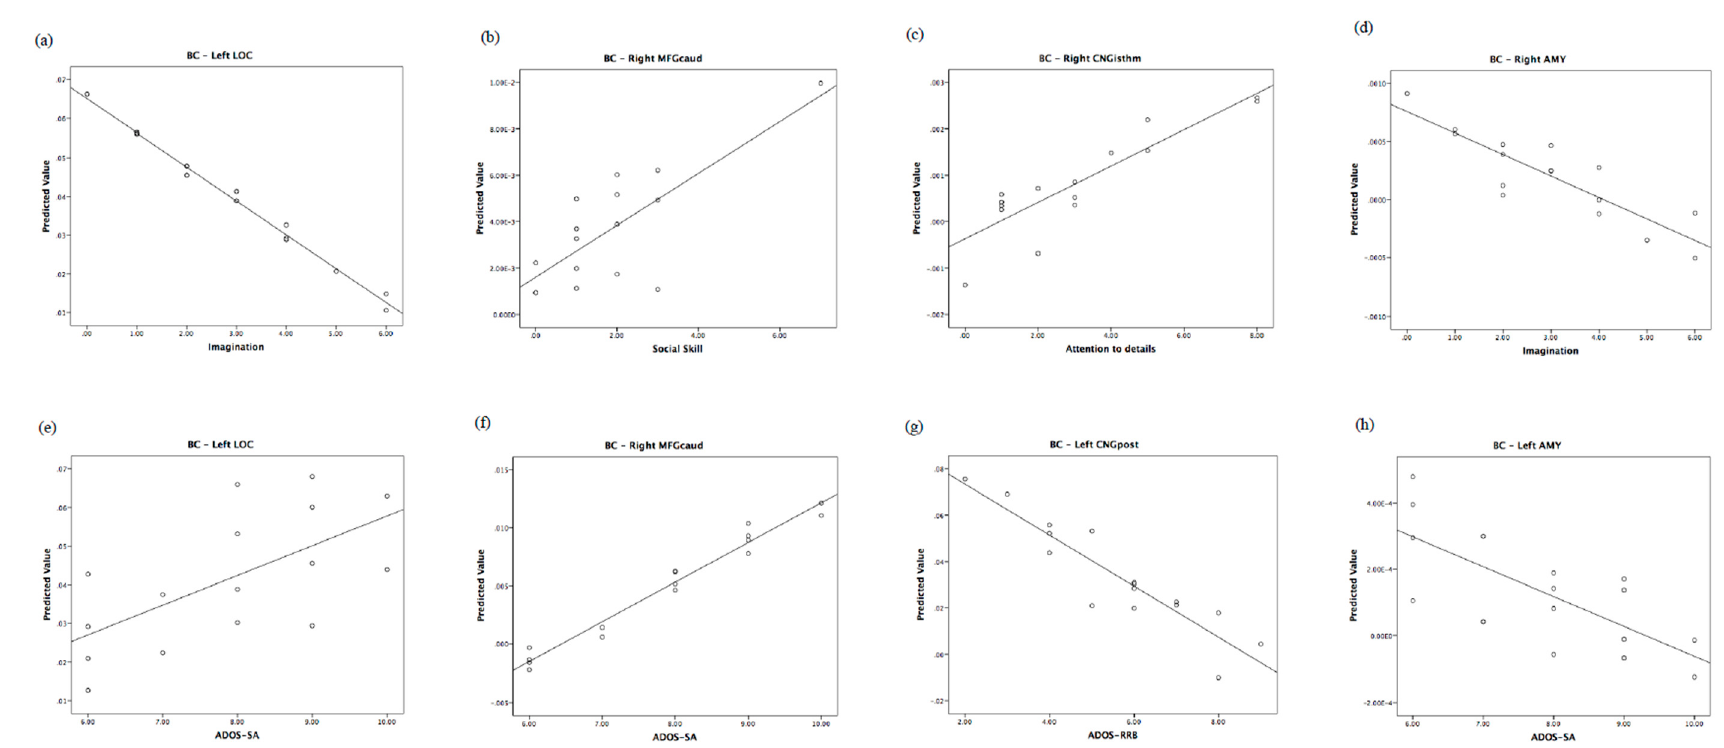
Figure 5. Regional betweenness centrality correlates of autistic traits in fathers and of autism severity in children. Top: predicted values vs. AQ domains in fathers. Bottom: predicted values vs. ADOS in children. BC: betweenness centrality.